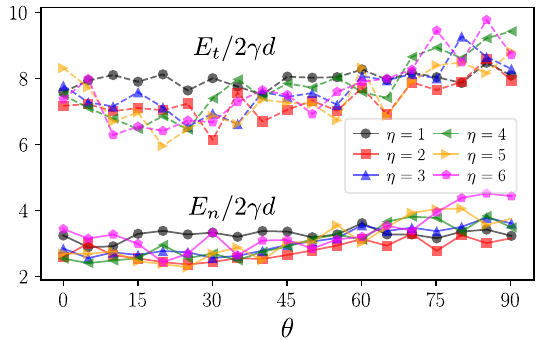
Figure 5. Total energy consume at failure in traction and shear- ing modes as a function of ✓ and di ↵ erent ⌘